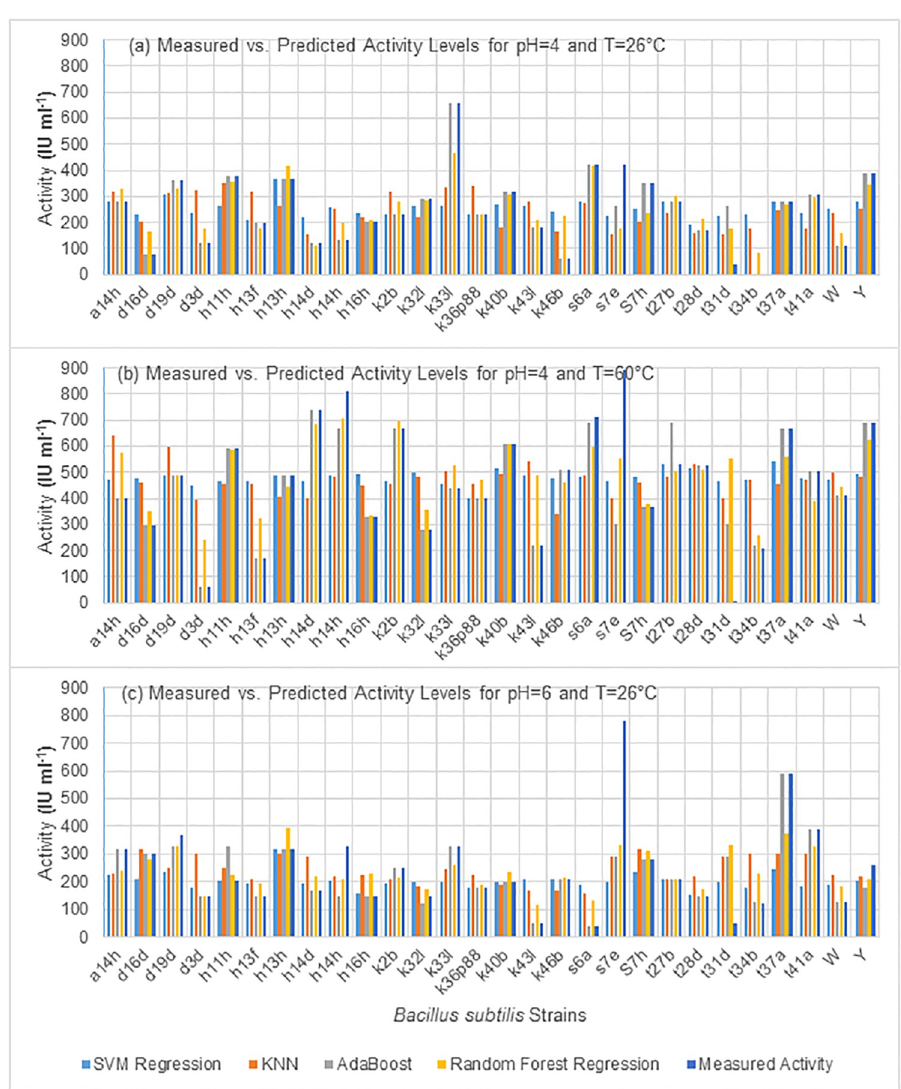
Fig 2. The activity of xylanase enzymes purified from different Bacillus subtilis strains vs. predicted activities by four computational models. The activities were determined in three different pH/temperature conditions. (a) pH = 4, T = 26˚C (b) pH = 4,T = 60˚C (c) pH = 6,T =